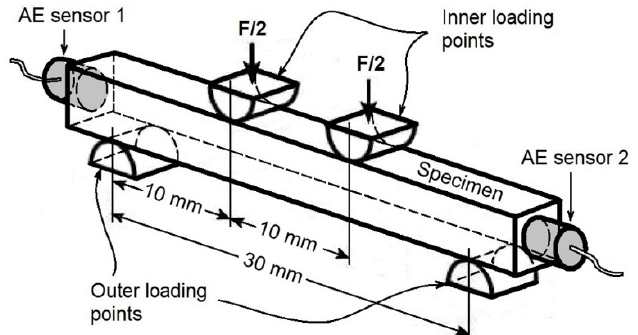
Figure 2. Schematic diagram of the experimental setup showing the four-point bending test and the locations of the Acoustic Emission (AE) sensors on the specimen.